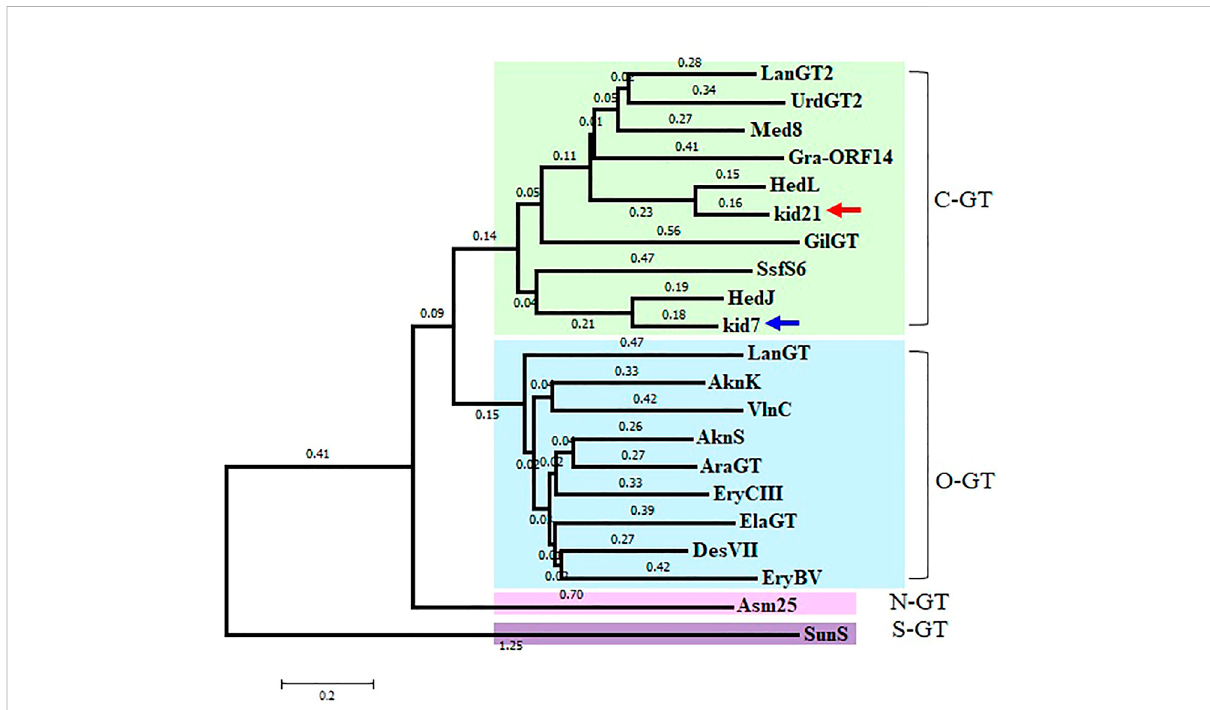
FIGURE 4 Phylogenetic analysis of 2 GTs, Kid7 and Kid21, compared to known GTs from Streptomyces. Arrow indicates the 2 GTs of this study. The sources and GenBank accession numbers of GTs involved in natural product biosynthesis by Streptomyces : AknK (AAF70102), AknS (AAF73455), AraGT (ABL09968), Asm25 (AAM54103), DesVII (Q9ZGH7), ElaGT (ADP68587), EryBV (AAB84072), EryCIII (A4F7P3), GilGT (AAP69578), Gra-ORF14 (CAA09635), HedJ (AA85354), HedL (AAP85354), LanGT (AAD13562), LanGT2 (AAD13553), Med8 (BAC79040), SsfS6 (ADE34512), SunS (KIX81208), UrdGT2 (AAF00209), and VlnC (BAJ52701). Amino acid sequences were aligned using the ClustalW method and the phylogenetic tree analysis was performed based on the sequence alignment using the Minimum Evolution method in the MEGA7